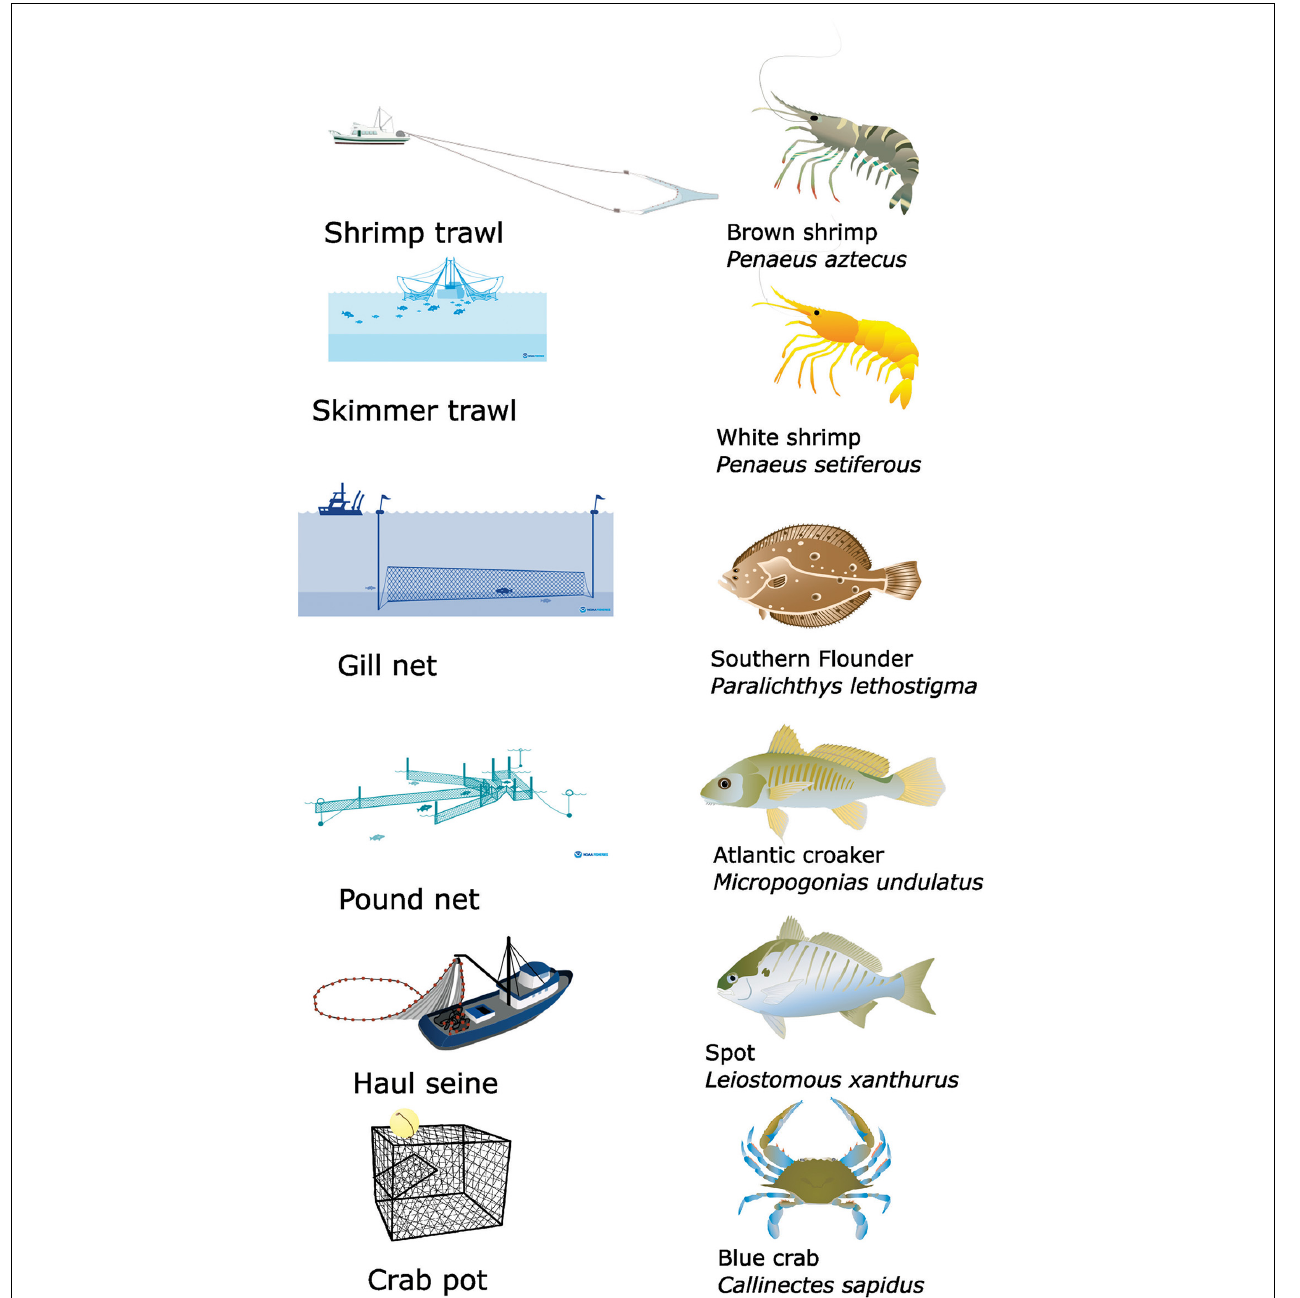
FIGURE 3 | Illustrations of the six main gear types used and primary species harvested by each gear in commercial fisheries in Core Sound, NC (USA) that were modeled in ECOPATH. Shrimp trawling targets brown shrimp Penaeus aztecus ; skimmer trawling targets white shrimp Penaeus setiferous ; gillnet targets southern flounder Paralichthys lethostigma ; pound net targets southern flounder Paralichthys lethostigma ; haul seine targets Atlantic croaker Micropogonias undulatus and spot Leiostomous xanthurus ; crab pot Callinectes sapidus. Images obtained from: Shrimp trawl, Crab pot, Haul Seine: Tracey Saxby, Integration and Application Network (https://ian.umces.edu/media-library). Skimmer trawl, gill nets, pound nets: https://www.fisheries.noaa.gov/national/bycatch/fishing-gear-skimmer-trawls; https://www.fisheries.noaa.gov/national/bycatch/fishing-gear-gillnets; and https://www.fisheries.noaa.gov/national/bycatch/fishing-gear-pound-nets.